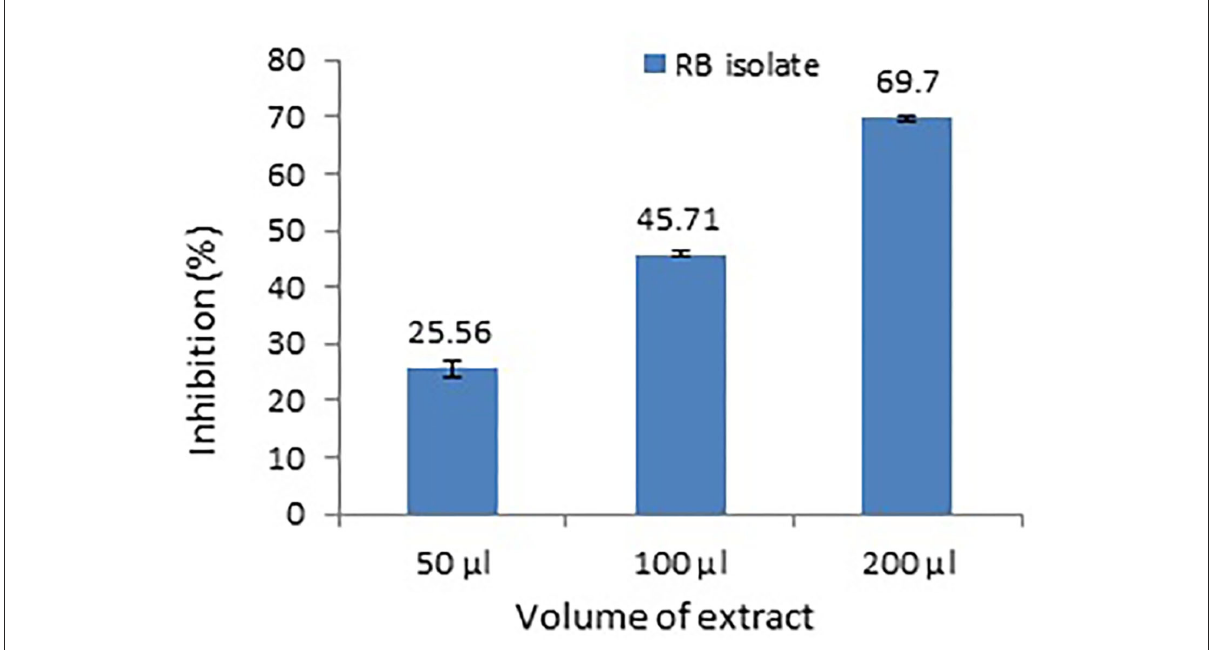
FIGURE3 Dose-dependent inhibition of violacein production in a monitor strain, C. violaceum MTCC2656. Values represent the mean of three replications. Bars indicate the standard error of the